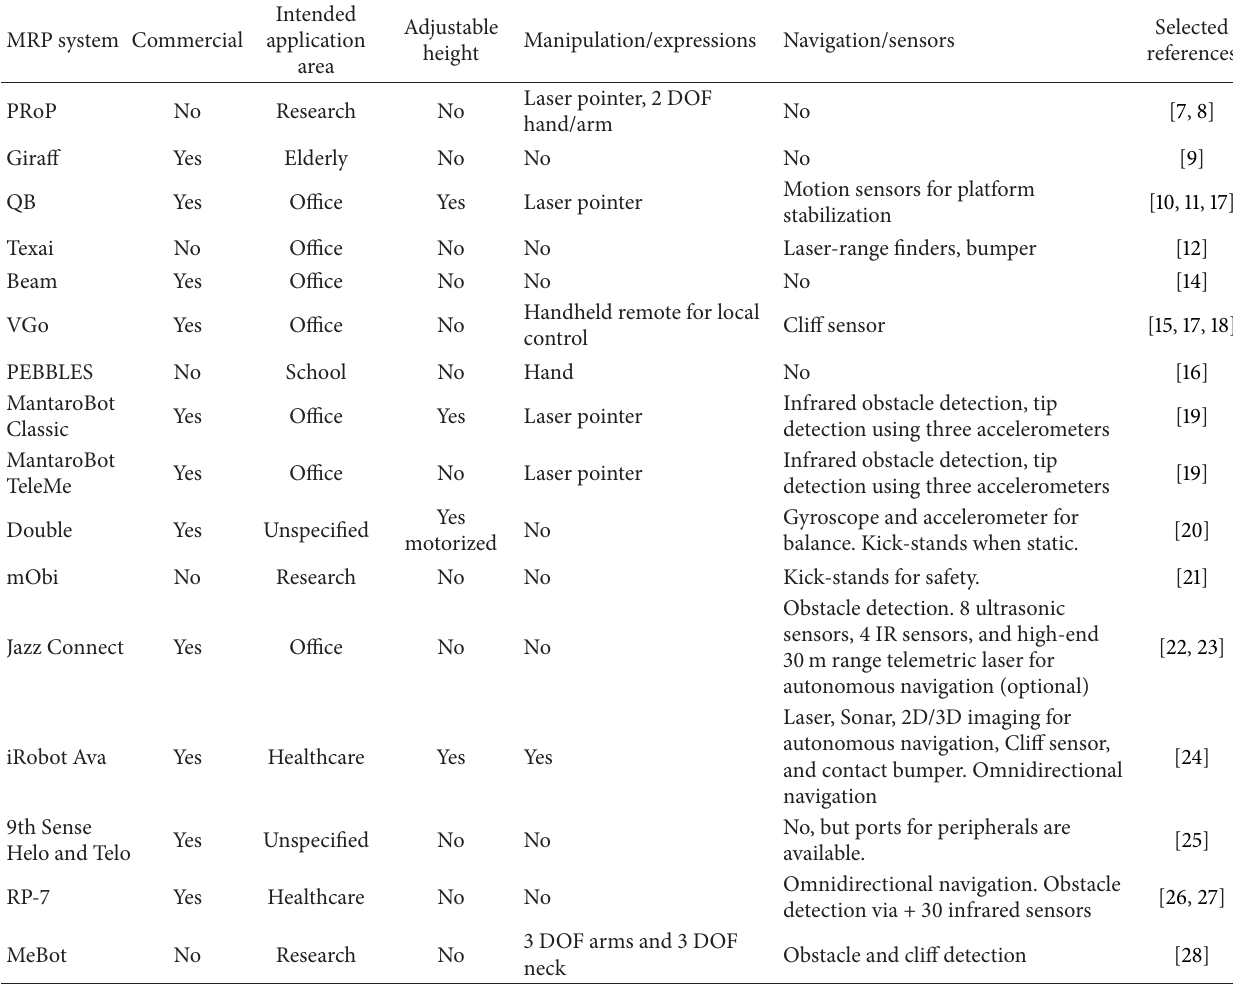
Table 1: An overview of common MRP systems appearing in the